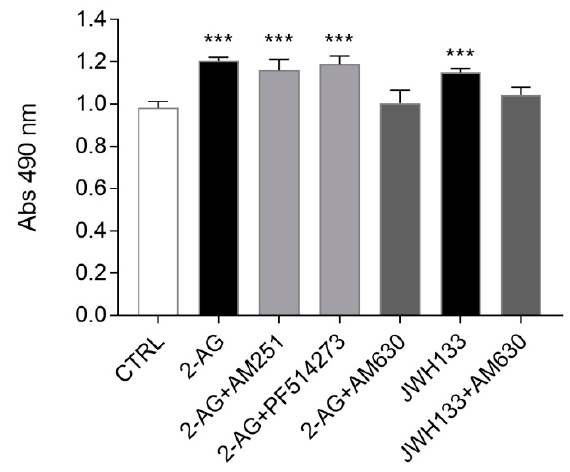
Figure 3. Evaluation of the effects of 2-AG and JWH133 alone or in the presence of specific CB1/CB2 antagonists on ST14A cell number. 2-AG (5 µ M) induces an increase of ST14A cell number after 24 h, with respect to control cells (CTRL). The effect was not reverted by the coadministration of 2-AG with the CB1 selective antagonists AM251 (250 nM) and PF514273 (50 nM); on the other hand, cell number was comparable to control when 2-AG was coadministered with the selective CB2 antagonist AM630 (300 nM). Similarly, the selective CB2 receptor agonist JWH133 (300 nM) induced ST14A cell number increase, which was specifically reverted by the coadministration of AM630 (300 nM). Data from the MTS assay are expressed as means ± SD of the absorbance ( λ = 490 nm); n = 5 replicates, 3 independent experiments. *** = p ≤ 0.001 vs. control.